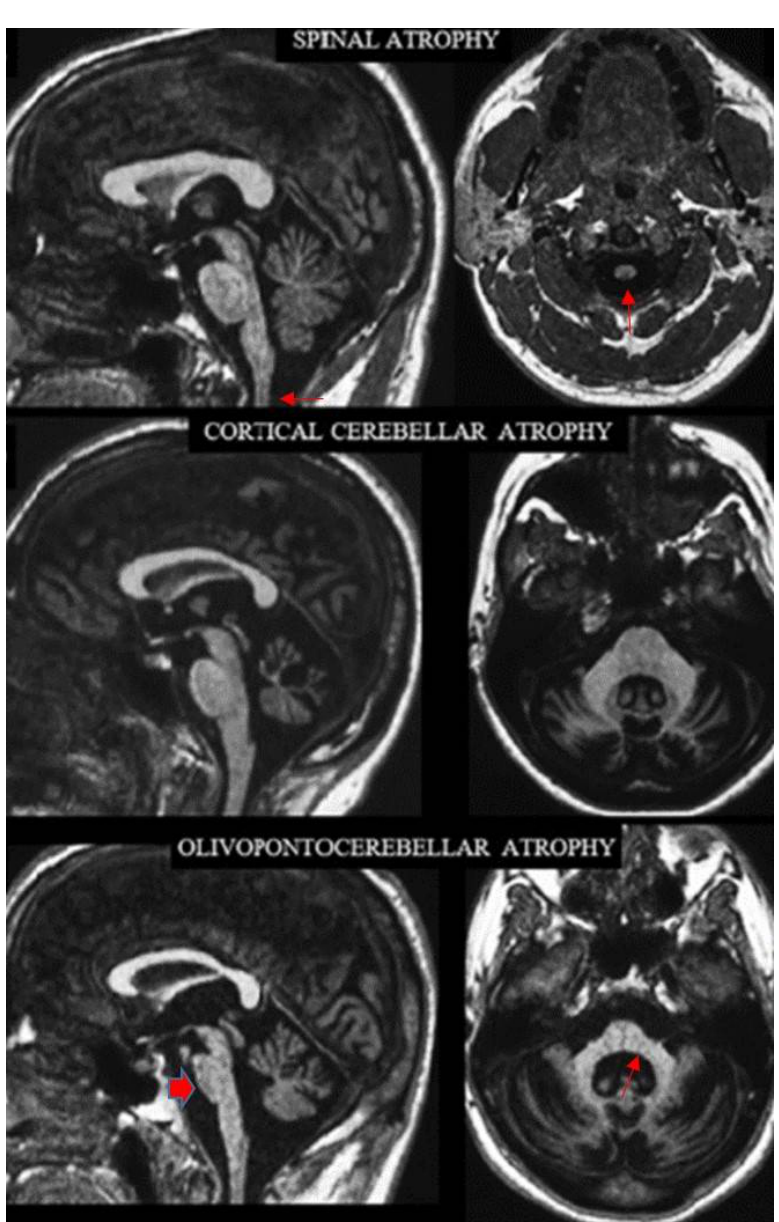
Figure 1. Sagittal (left column) and axial (right column) T 1 -weighted MR images in three exemplificative patients show the three CNS atrophy patterns underlying progressive ataxias (modified by ref. [29]). The typical features of spinal atrophy (SA), namely thinned medulla and cervical spinal cord (arrows) with normal volume of the pons and cerebellar vermis, are observed in a patient with Friedreich ataxia (top). Loss of bulk of the vermis and cerebellar hemispheres with enlarged interfolia spaces but normal volume of the pons, middle cerebellar peduncles and of the cervical spinal cord are the hallmark of cortical cerebellar atrophy (CCA) in a patient with sporadic adult-onset ataxia (SAOA) (mid). Atrophy of the brainstem, more pronounced in the inferior portion of the basis pontis (arrowhead), of the vermis, of the middle cerebellar peduncles (arrow) and of the cerebellar hemispheres characterizes olivopontocerebellar atrophy (OPCA) in a patient with SCA2 (bottom). Note in the bottom images the thinning of the superior cervical medulla that can be observed in SCA2 as result of secondary axonal and trans-synaptic degeneration.